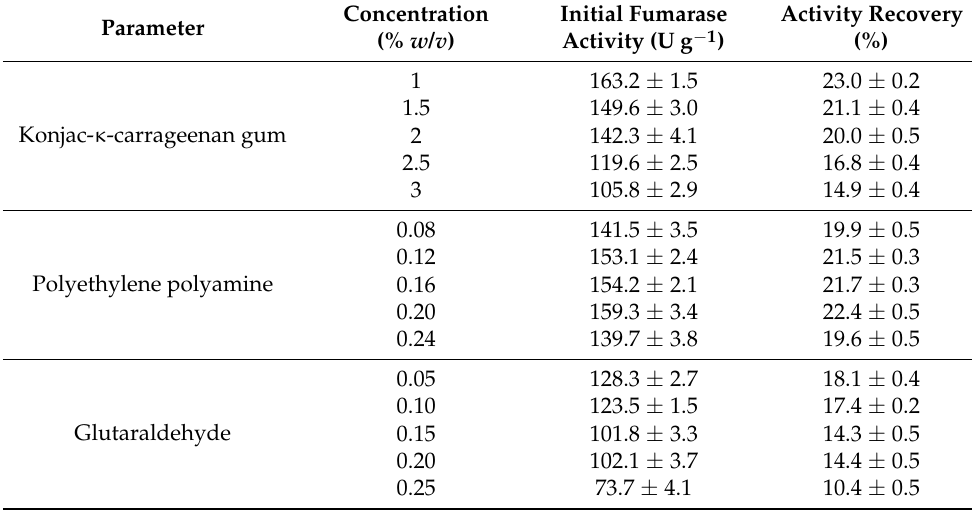
Table 1. Optimization of different parameters for the immobilization of partially purified fumarase in konjac- κ -carrageenan beads.